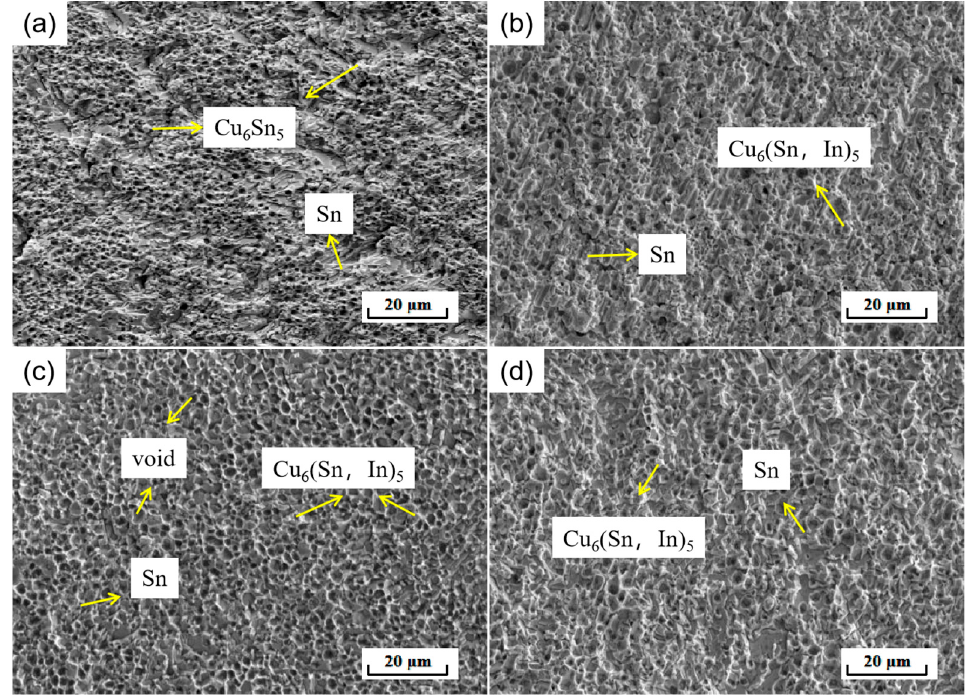
Figure 14. Fracture microstructure of SnBiAg–xIn (x = 0, 0.5, 1.0, 1.5)/Cu soldered joints: ( a ) SnBiAg/Cu; ( b ) SnBiAg0.5In/Cu; ( c ) SnBiAg1.0In/Cu; ( d ) SnBiAg1.5In/Cu.